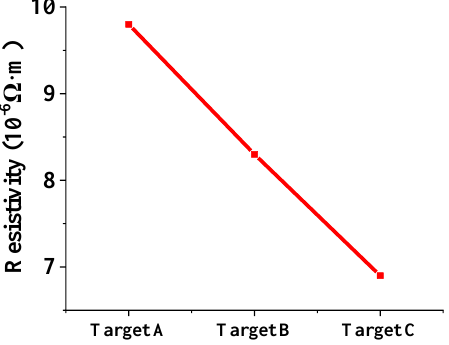
Figure 7. Resistivity of films prepared by Ti targets with different purities.